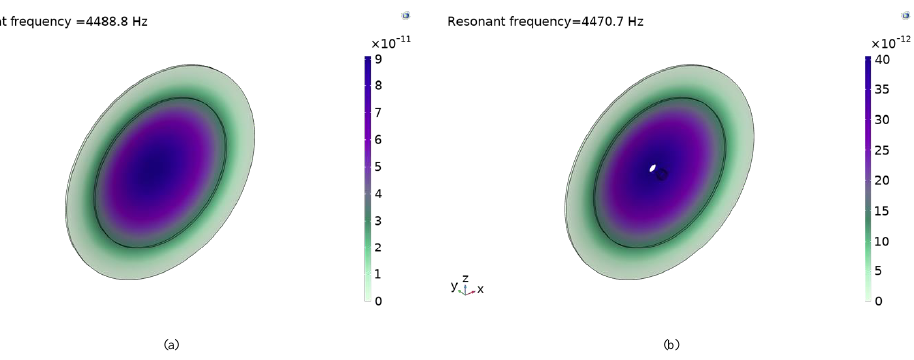
Figure 7. The first − order modes of the vibrators: ( a ) of the vibrator; ( b ) of the vibrator with hole.